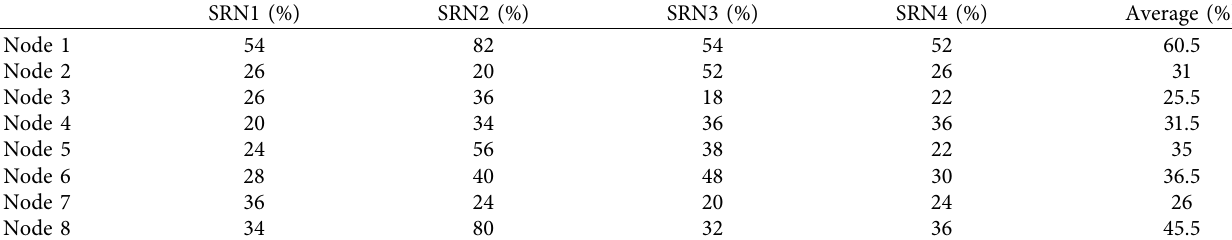
Table 3: HPE recognition rates for four types of SRN.